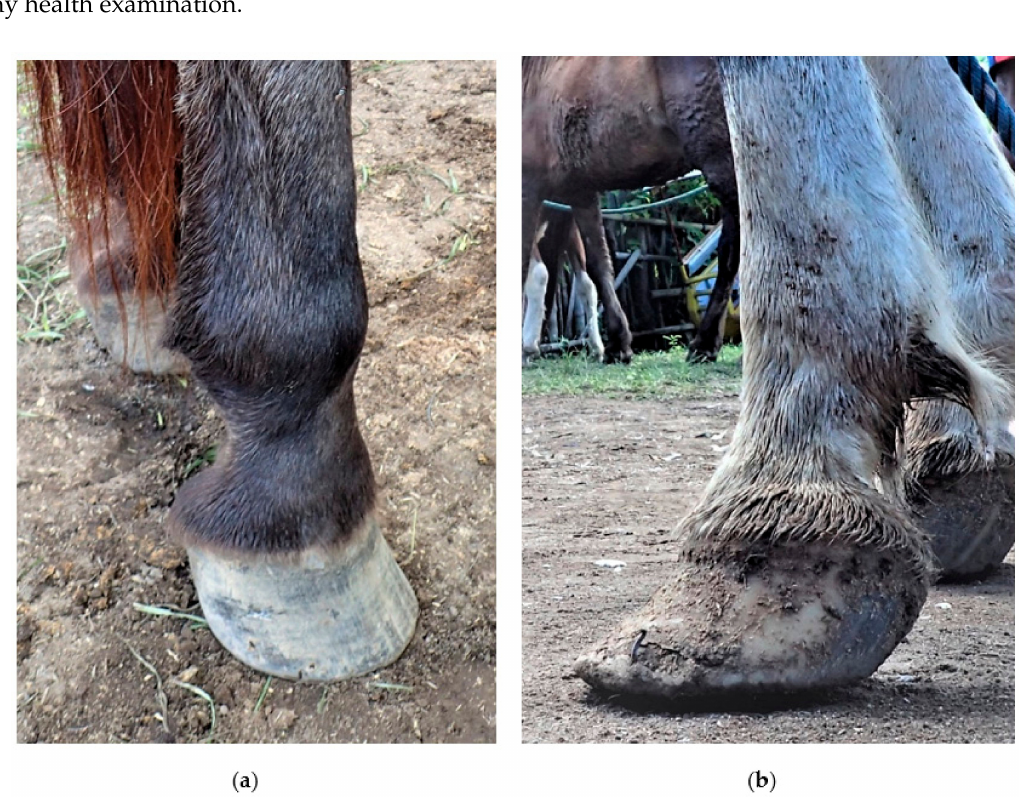
Figure 1. Hoof pathology grading scores: ( a ) 1 and ( b )